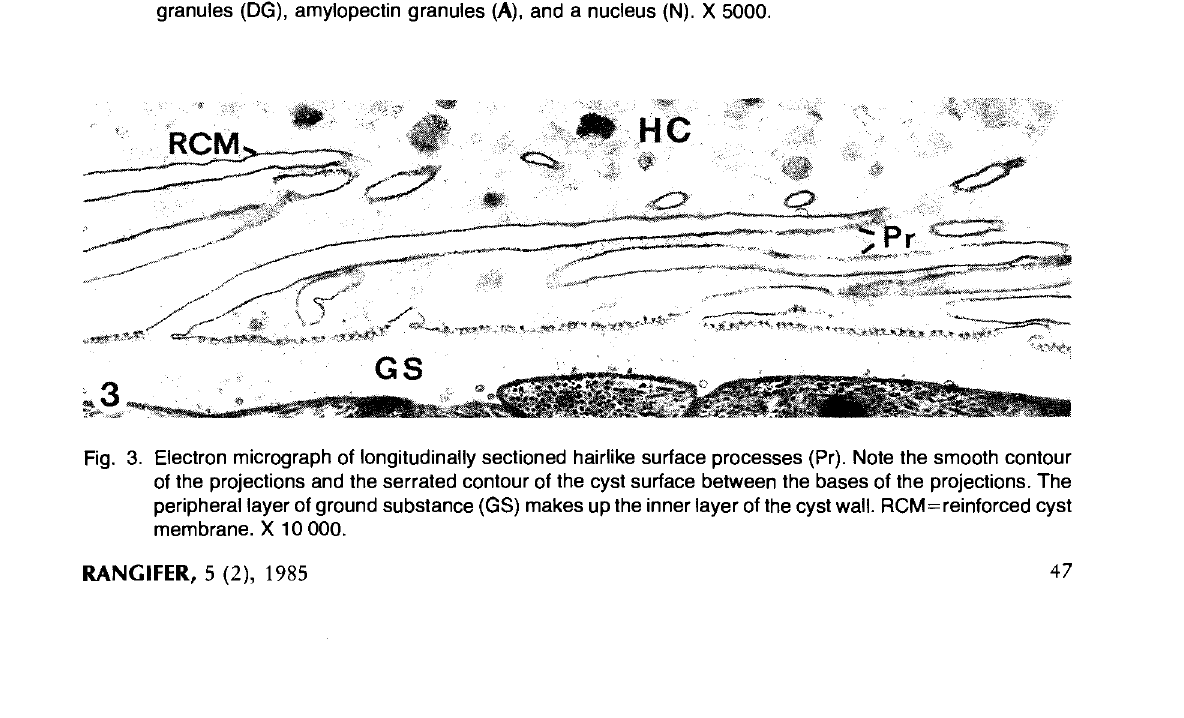
Fig. 2. Oblique section through S. rangi cyst, showing compartments with metrocytes (Mc) and cystozoites (Cz), and numerous portions of variously sectioned cyst surface processes (Pr). HC=host cell sarcoplasm. HCN=host cell nucleus. The cystozoites display a conoid (Co), rhoptries (Rh), micronemes (Mn), dense granules (DG), amylopectin granules (A), and a nucleus (N). X 5000.